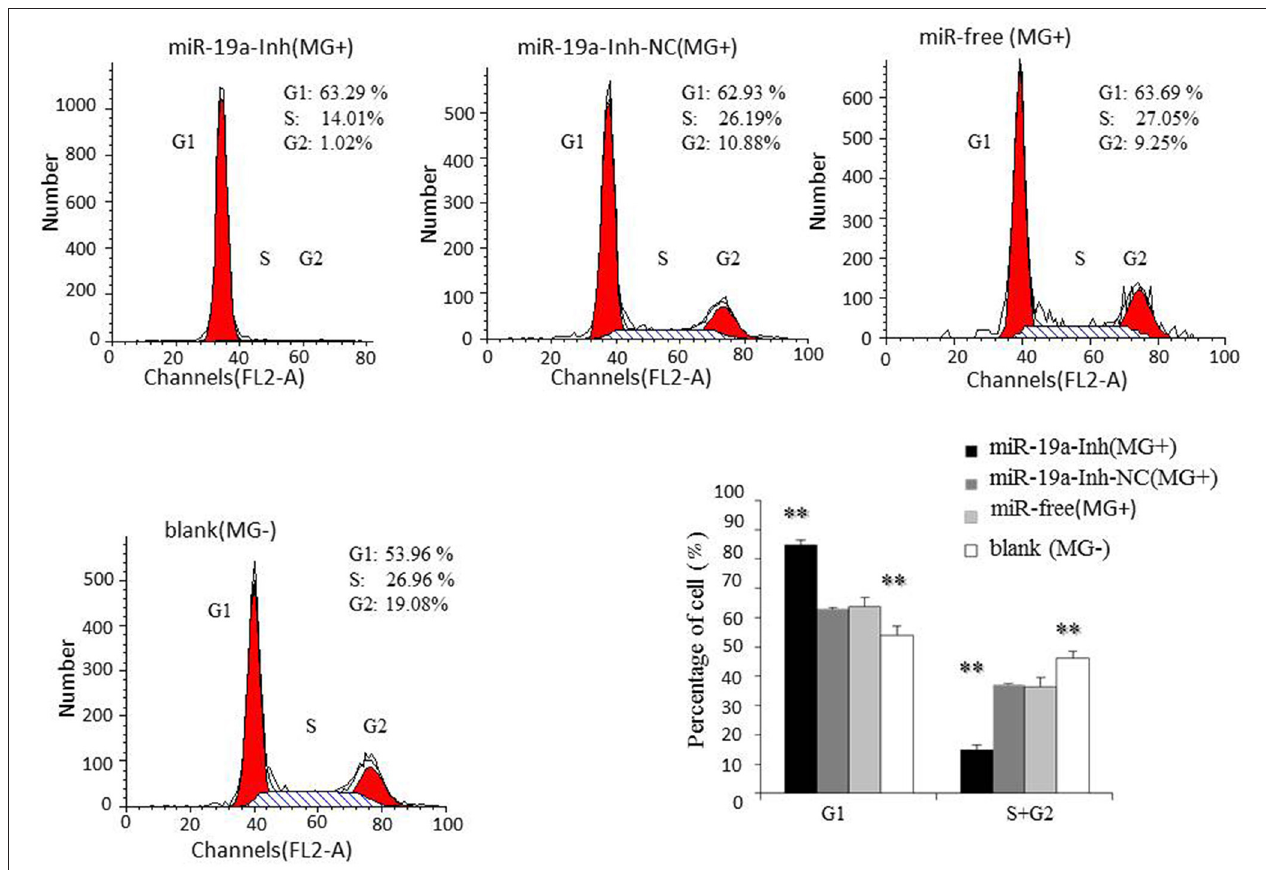
FIGURE 7 | The effect of gga-miR-19a inhibitor on the distribution of DF-1 cells in the cell cycle. DF-1 cells were transfected with miR-19a-Inh or miR-19a-Inh-NC and were incubated for 4 h. The cells were then infected with MG-HS strain. Three control groups, including miR-19a-Inh-NC (MG + ), miR-free (MG + ) and blank (MG − ), were used. At 48 h post-transfection, the cell cycle was analyzed using a flow cytometer. All values are represented as the mean ± SD of three independent experiments in triplicate. Significant differences are denoted as ** P < 0.01.